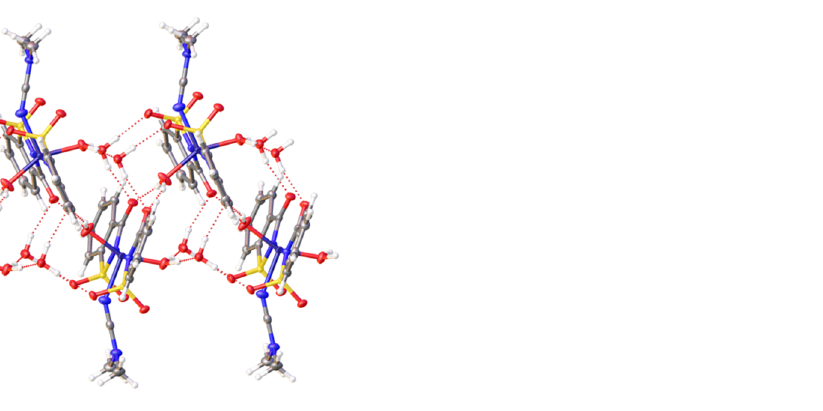
Figure 3. A fragment of crystal packing of 1 · 2H 2 O with the interligand hydrogen bonds shown in dotted lines.